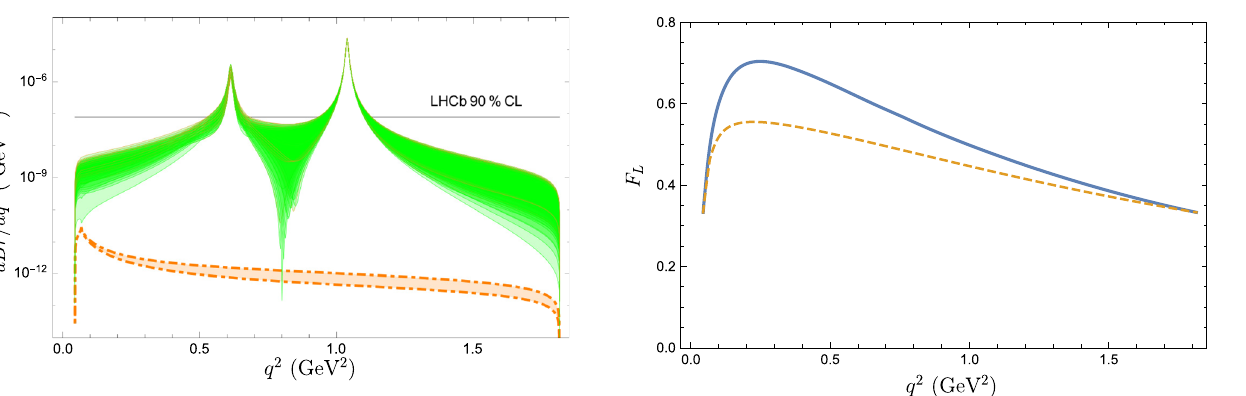
Fig. 4 Prediction for the fraction of longitudinally polarized dileptons F L ( q 2 ) in the (cid:2) c → p μ + μ − decay. The dashed curve corresponds to the nonresonant predictions, while the solid curve shows results with the inclusion of the vector meson